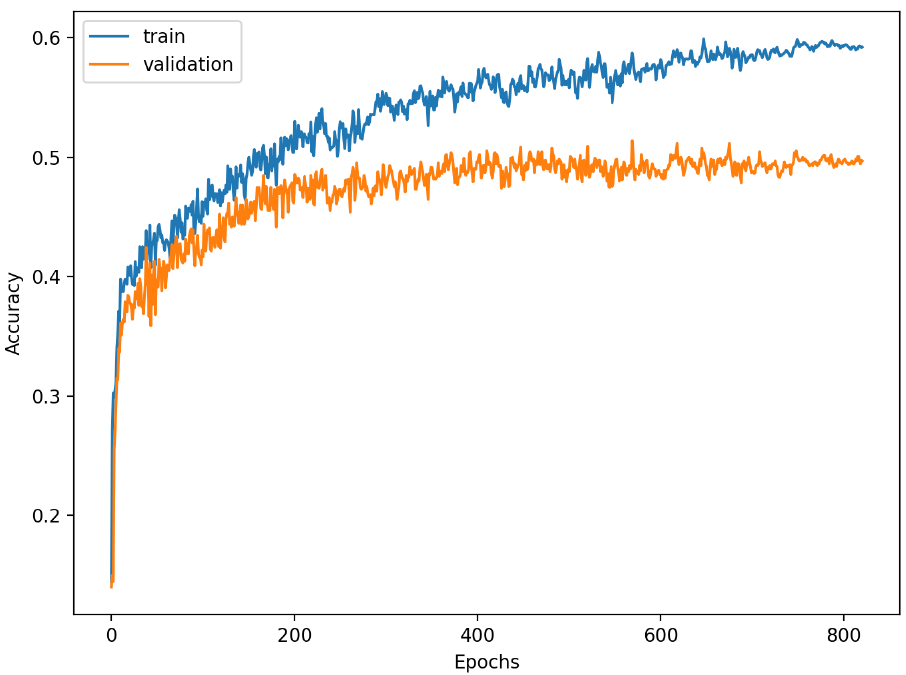
Figure 17. Learning process of the Neural Network for Few-Shot (20 classes) with proximity-based classification.